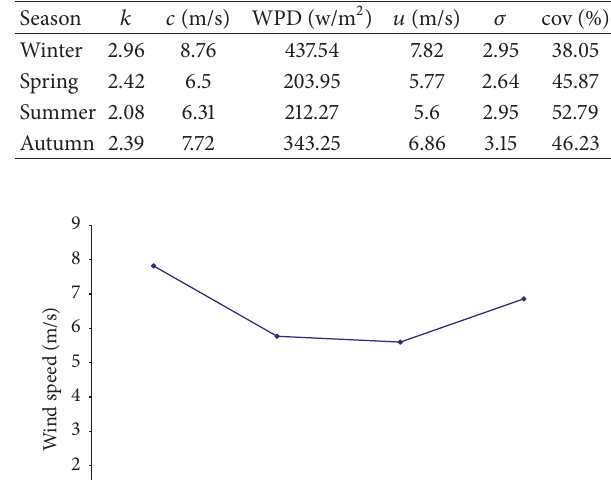
Table 3: Wind power classification [21]. Power class